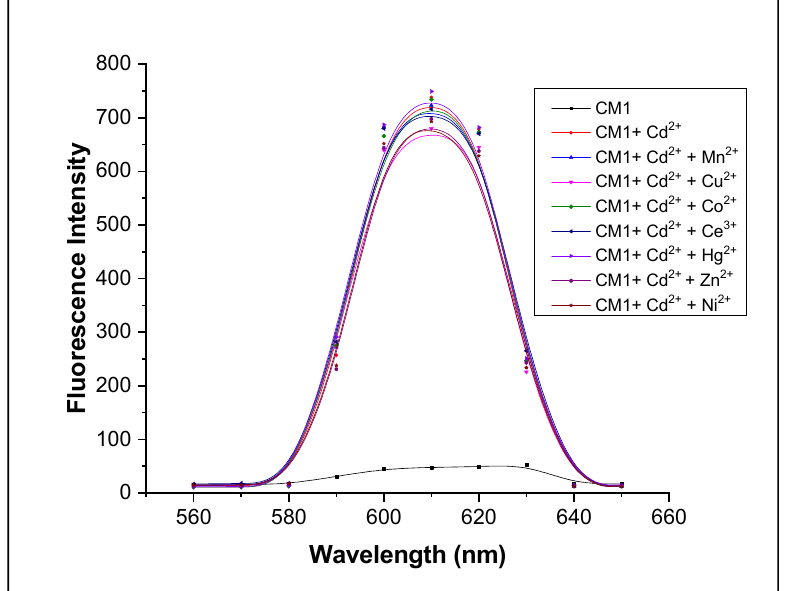
Figure 7. Interference study of CM1 (10 µM) and Cd 2+ (18 µM) and interfering metal ions (200 µM) at λ ex = 390 nm and λ em = 610 nm.